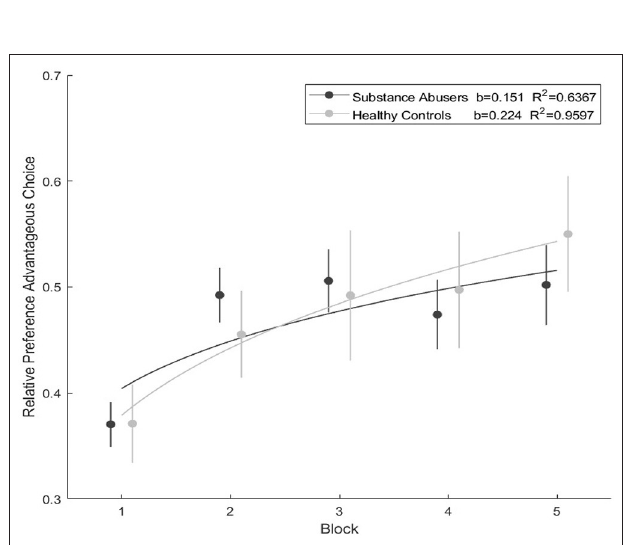
In the most favorable decision scenario (gain = 30; loss = − 250; risk = 1), and in the most unfavorable decision scenario (gain = 10; loss = − 750; risk = 3), substance abusers tended to select more cards than healthy users in both scenarios, though these differences were not significant (all p -values >